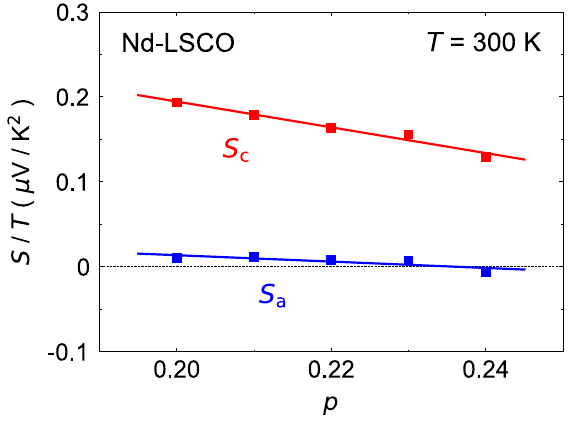
FIG. 6. S a =T (blue) and S c =T (red) at T ¼ 300 K (and H ¼ 0 ) as a function of the doping for Nd-LSCO p ¼ 0 . 20 , 0.21, 0.22, 0.23, and 0.24. Solid lines are a linear fit to the data.